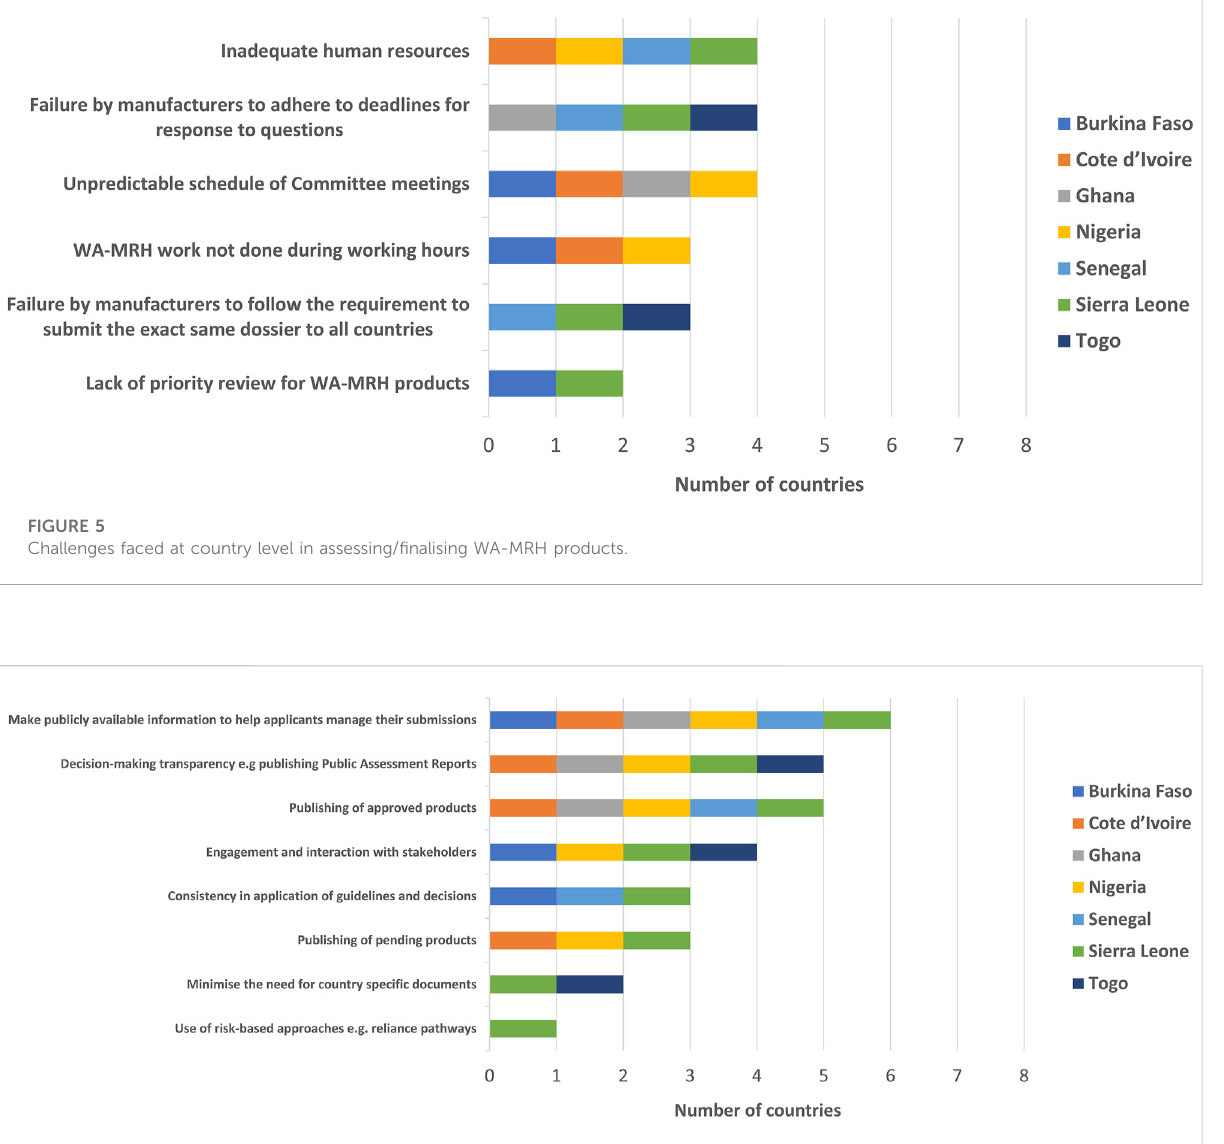
FIGURE 6 Ways to improve effectiveness of the WA-MRH